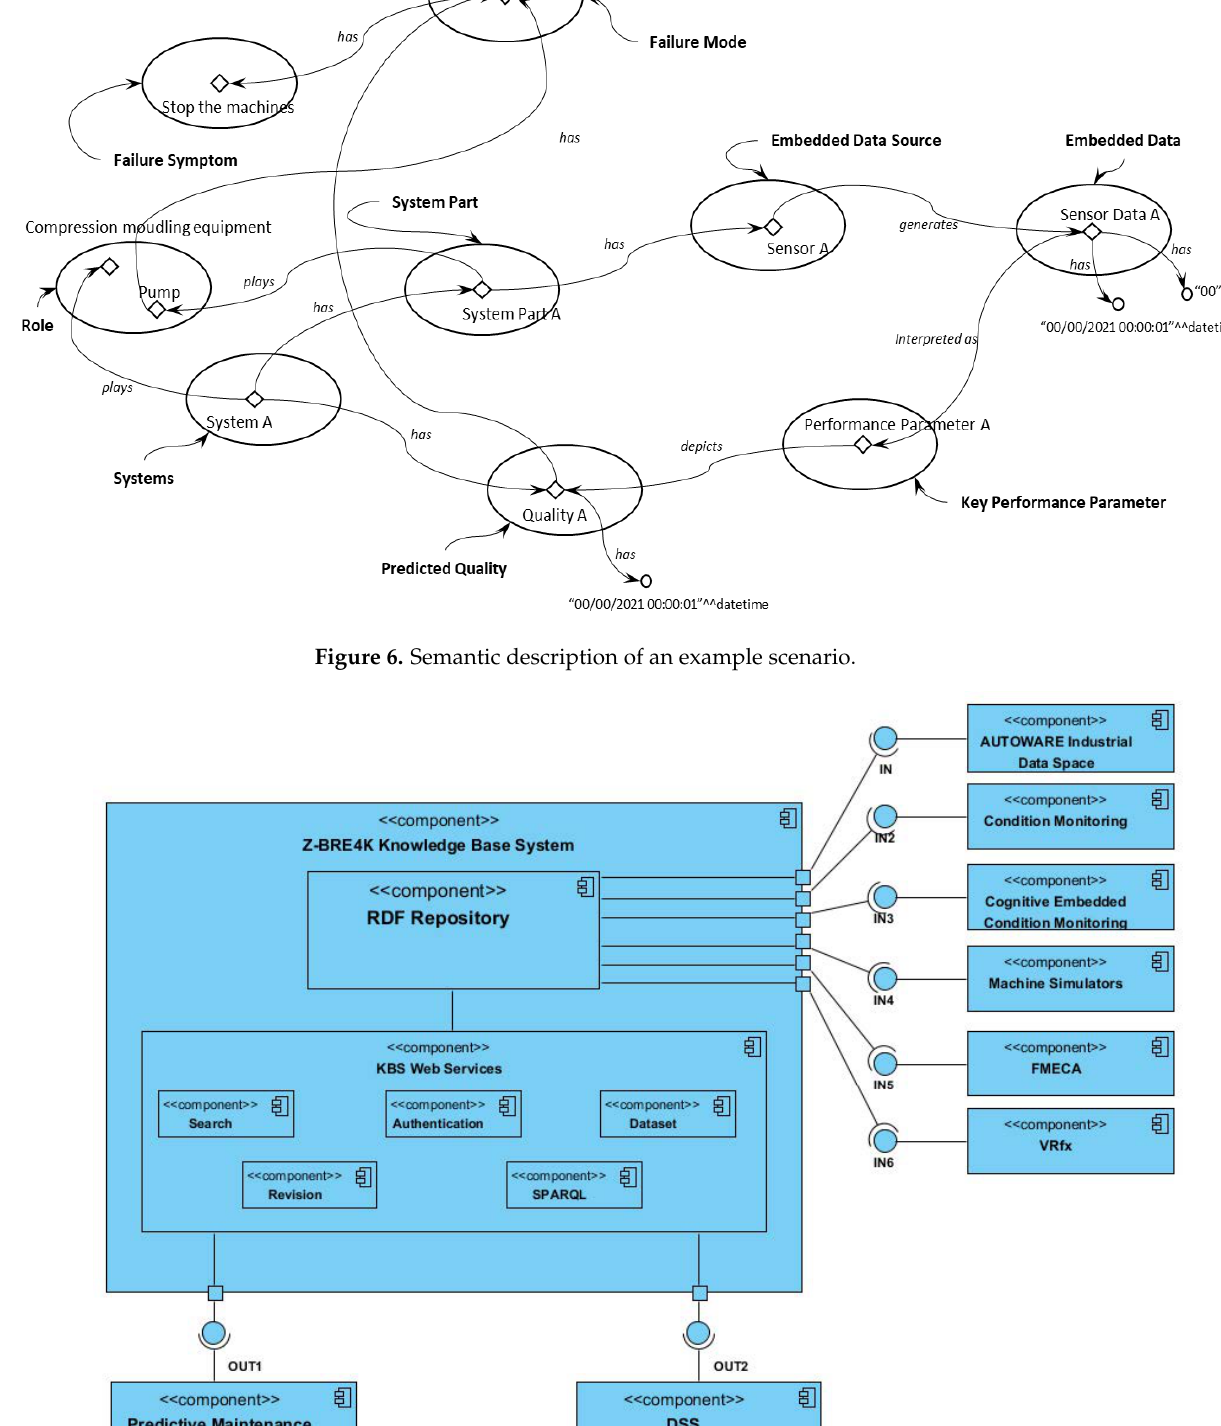
Figure 7. The knowledge base system’s component diagram.